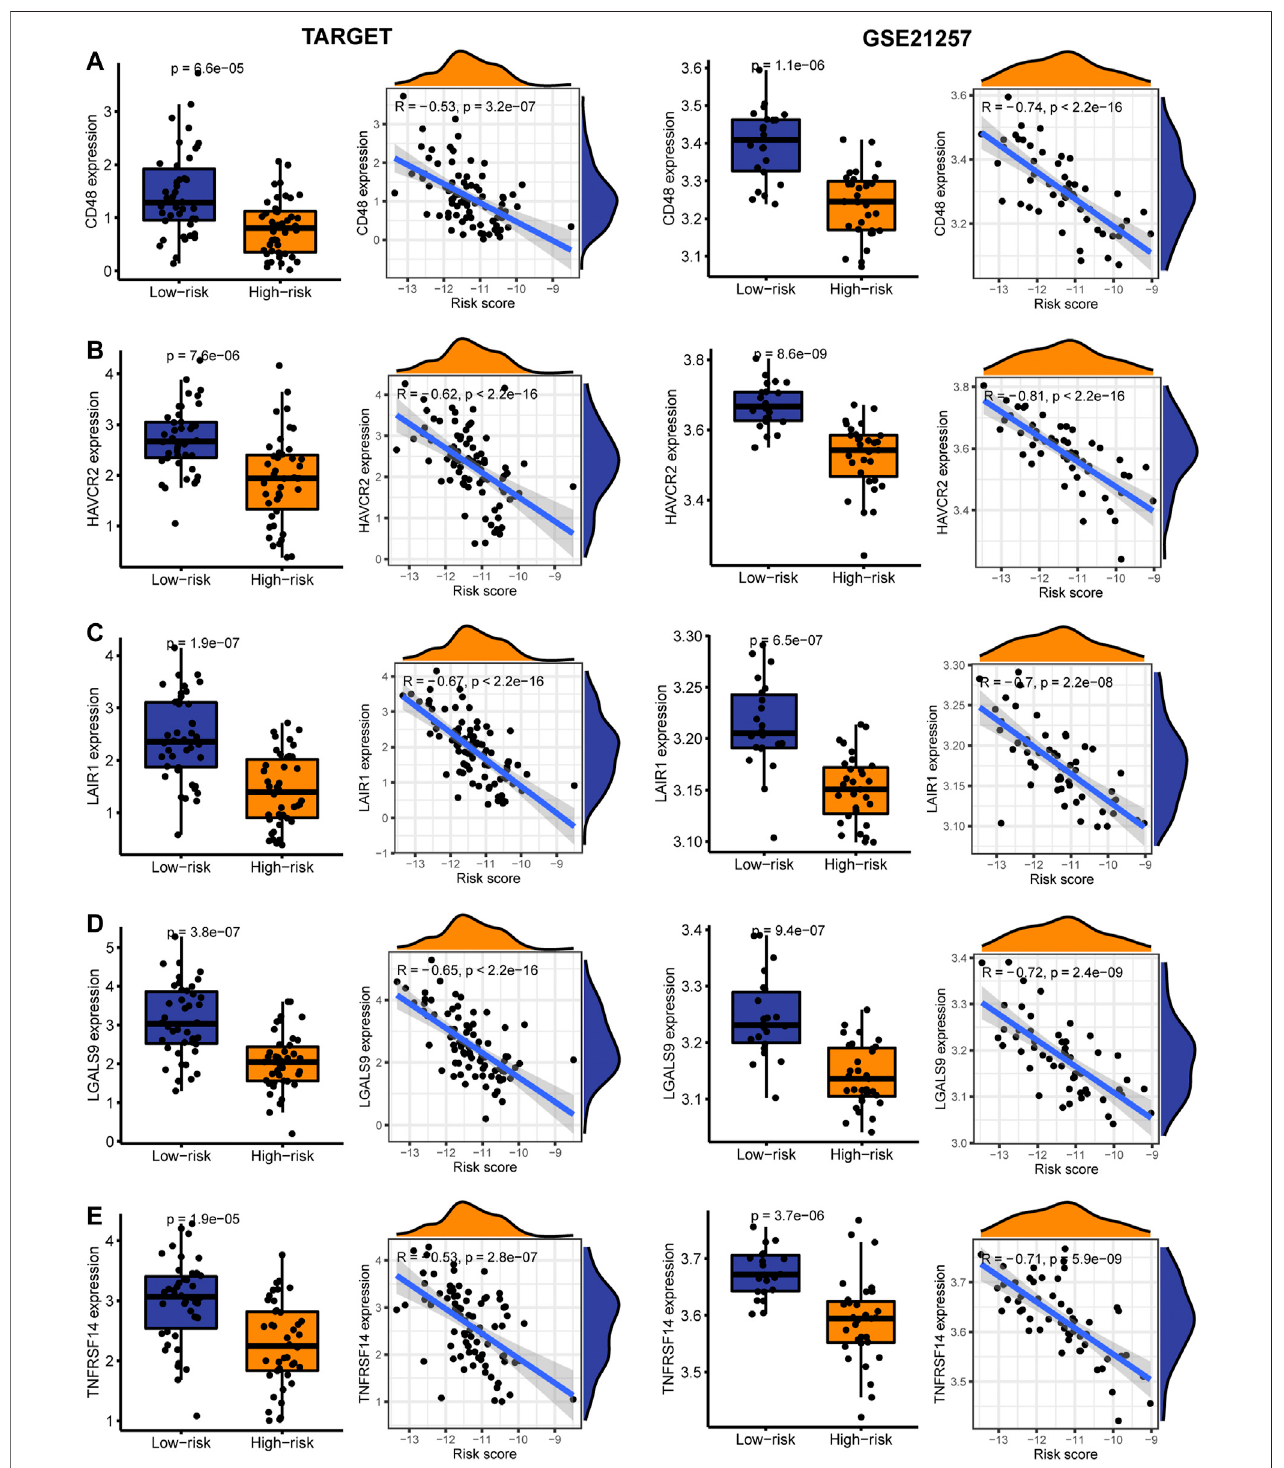
FIGURE 8 | The expression and correlation between immune checkpoints in high- and low-risk patients in the TARGET and GSE21257 cohorts. (A) CD48 (B) HAVCR2 (C) LAIR1 (D) LGALS9 (E) TNFRSF14.